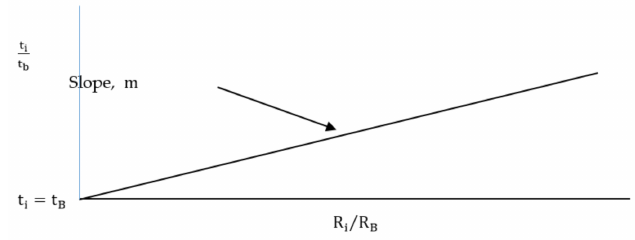
Figure 9. Manufacturing time against preform